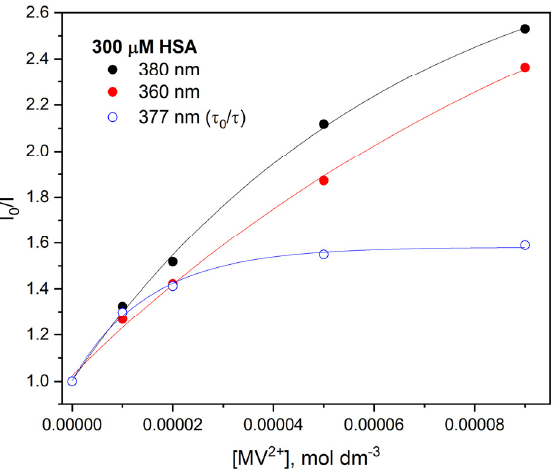
Figure 4. Stern–Volmer plot of changes in fluorescence intensity (I 0 /I) of HSA (300 µM) versus the concentration of MV 2+ (0–90 mM). The I 0 and I value for a given quencher concentration were read from the HSA emission spectra recorded in the absence and presence of MV 2+ , respectively ( λ max = 360 and 380 nm). The τ 0 and τ value denote the fluorescence lifetimes of HSA in the absence and presence of MV 2+ , respectively ( λ exc = 337 nm).